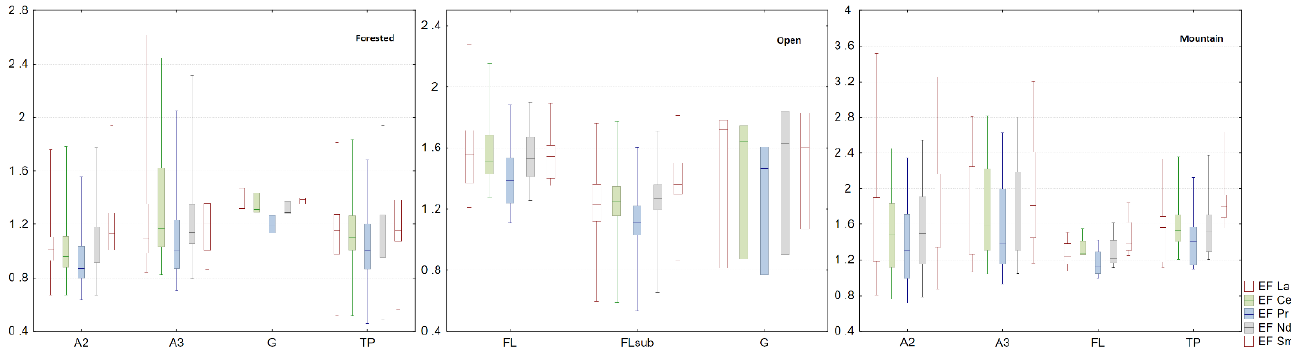
Figure 6. Box-and-whisker plots (whiskers: min-max, box: upper and lower quartile, line: median) of EF of: La, Ce, Pr, Nd, and Sm for different types of κ distribution in soil profile, grouped by the area type: forested, open, mountain; lack of whiskers in plots for type G results from low number of soil cores in these groups (only 3 per group)